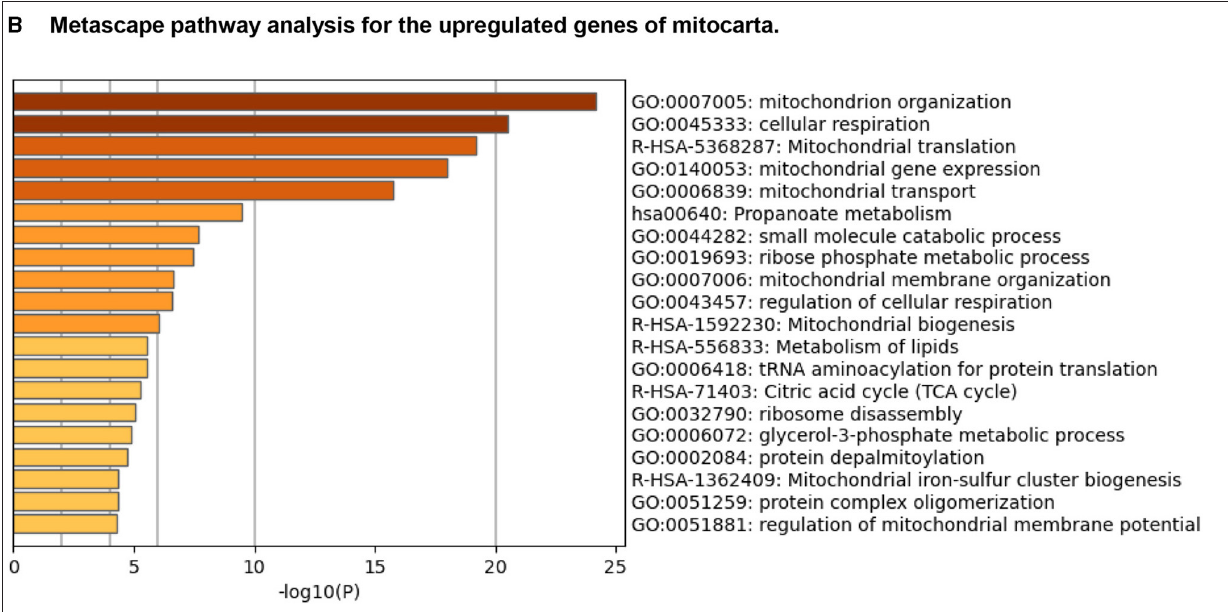
(C) LPIs upregulate 18 out of 165 ROS regulators in HAECs. ROS regulators: LPI treated HAECS vs Control HAECS. Upregulated genes: 18 (18/165 ∼ 10.9%).